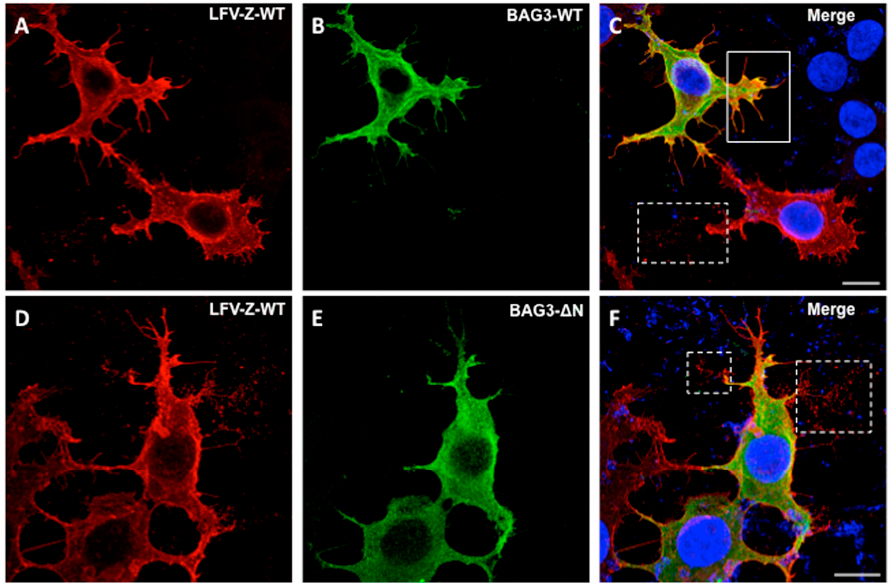
Figure 5. Intracellular localization of LFV-Z and BAG3-WT using confocal microscopy. HEK293T cells were co-transfected with LFV-Z and BAG3-WT ( A – C , top row), or LFV-Z with BAG3- Δ N mutant ( D – F , bottom row). Abundant LFV-Z VLPs (red) were observed to be released from cells co-expressing the BAG3- Δ N mutant (bottom row, merge ( F ), white dotted squares), compared to that released from cells expressing LFV-Z + BAG3-WT (top row, merge ( C ), solid white square). Scale bar = 10 µm.